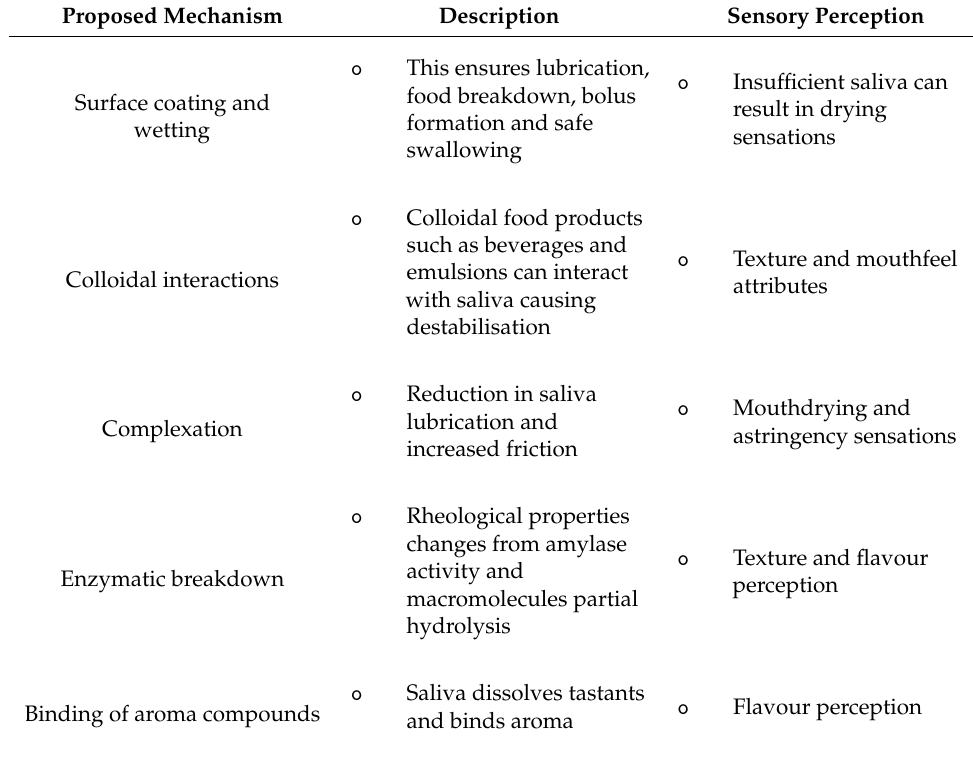
Figure 4. Saliva flow contribution from salivary glands [191]. Table 5. Summary of proposed food and saliva interactions and effect on sensory perception, as suggested by Mosca and Chen [196].